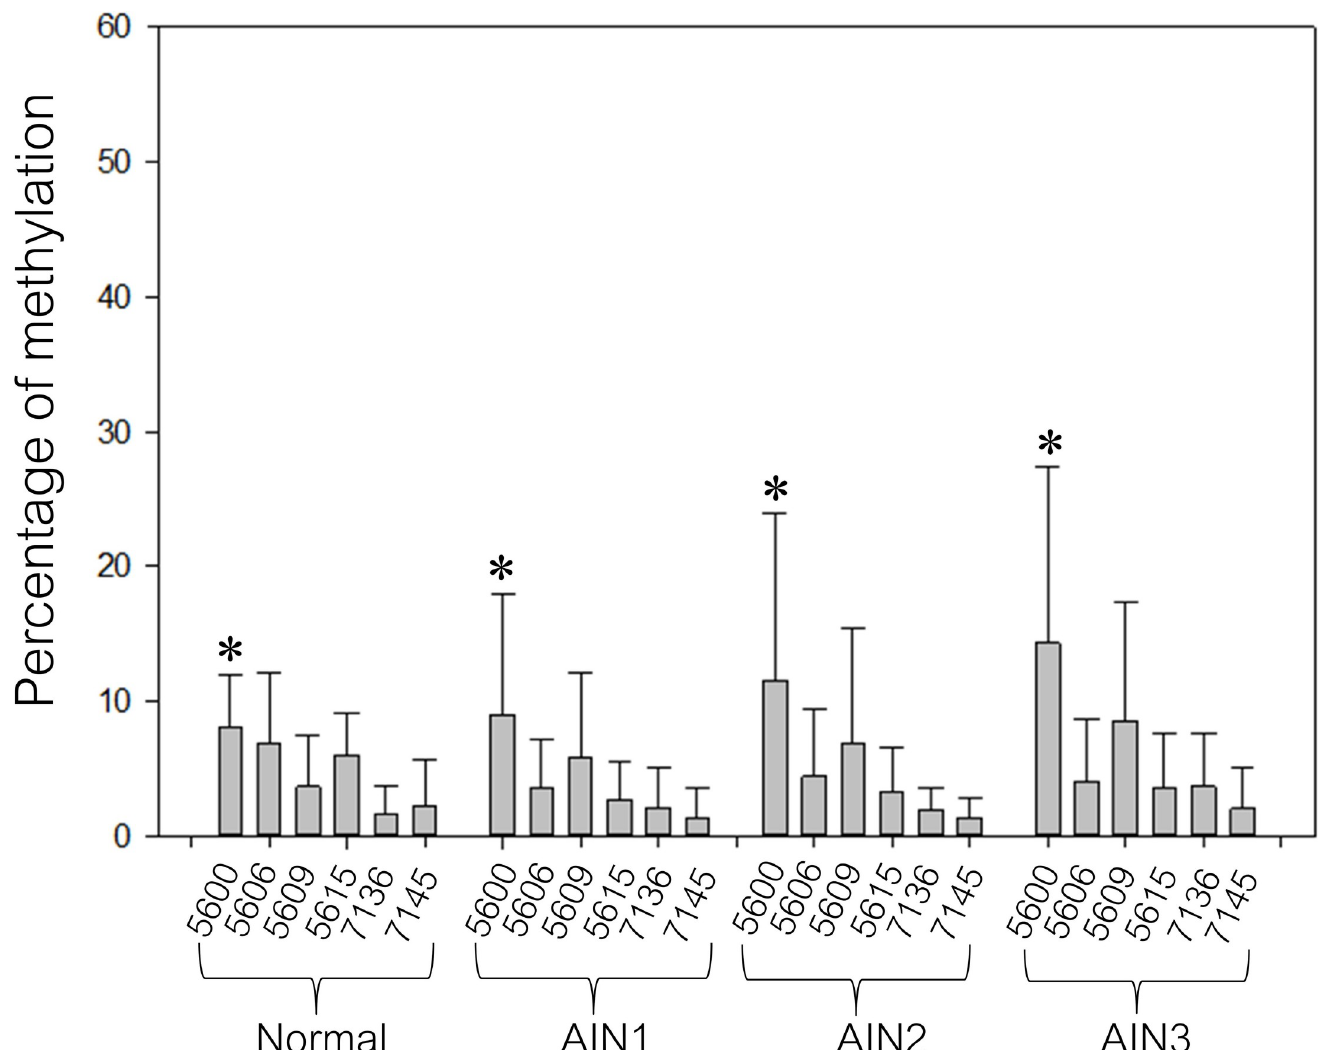
Fig 3. Methylation percentage of the L1 gene in anal samples stratified by histology as normal, AIN1, AIN2 and AIN3. The error bars in the bar graph represent the mean with standard deviation (SD). The Kruskal–Wallis test was used to compare the differences among the groups. � denotes statistically significant differences among the different lesion severities of CpG 5600 (P <